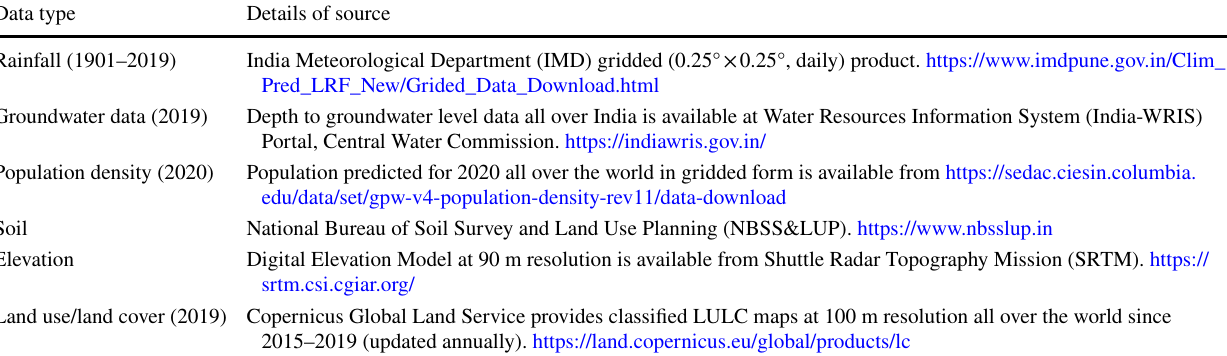
Table 1 Details of the data types used in this study and their sources